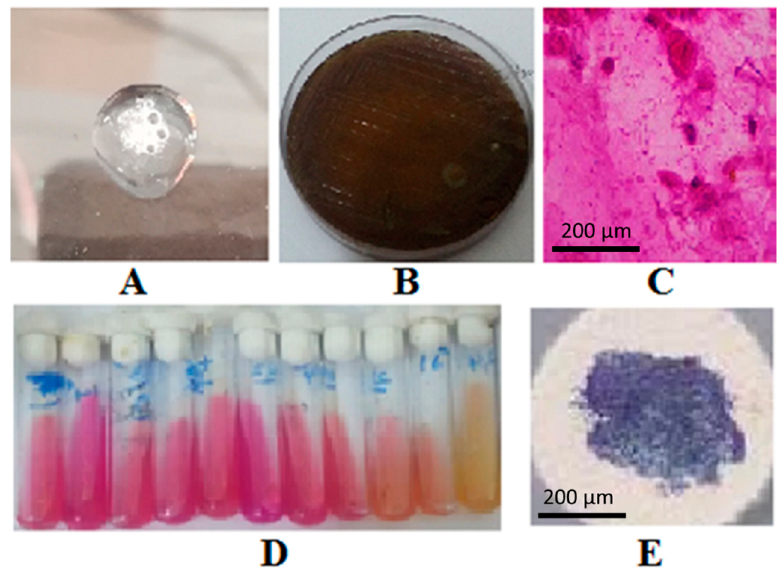
Figure 7. H. pylori Bacterial Diagnostic Tests Catalase ( A ), Positive culture on selected culture media of Columbia blood agar ( B ), Curved Bacillusand Gram-negative ( C ), Urea test ( D ) and Positive oxidase test ( E ).